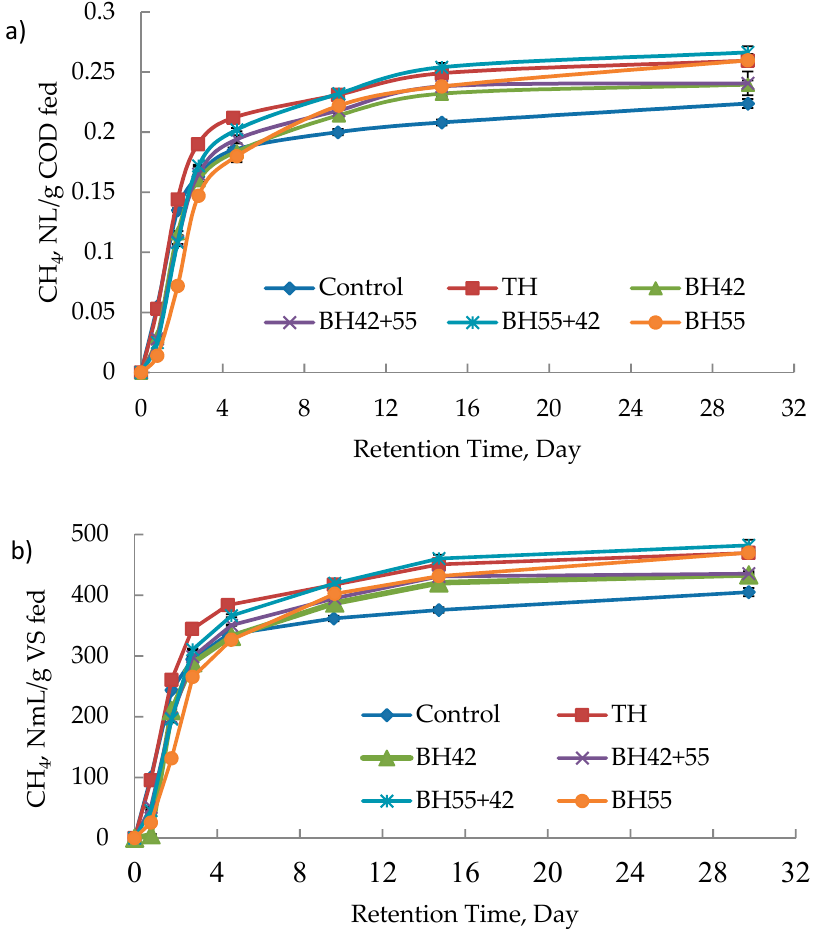
Figure 5. CH 4 yields of untreated and TH and BH-treated sludge substrate; ( a ) CH 4 NmL/g COD fed and ( b ) CH 4 NmL/g VS fed.